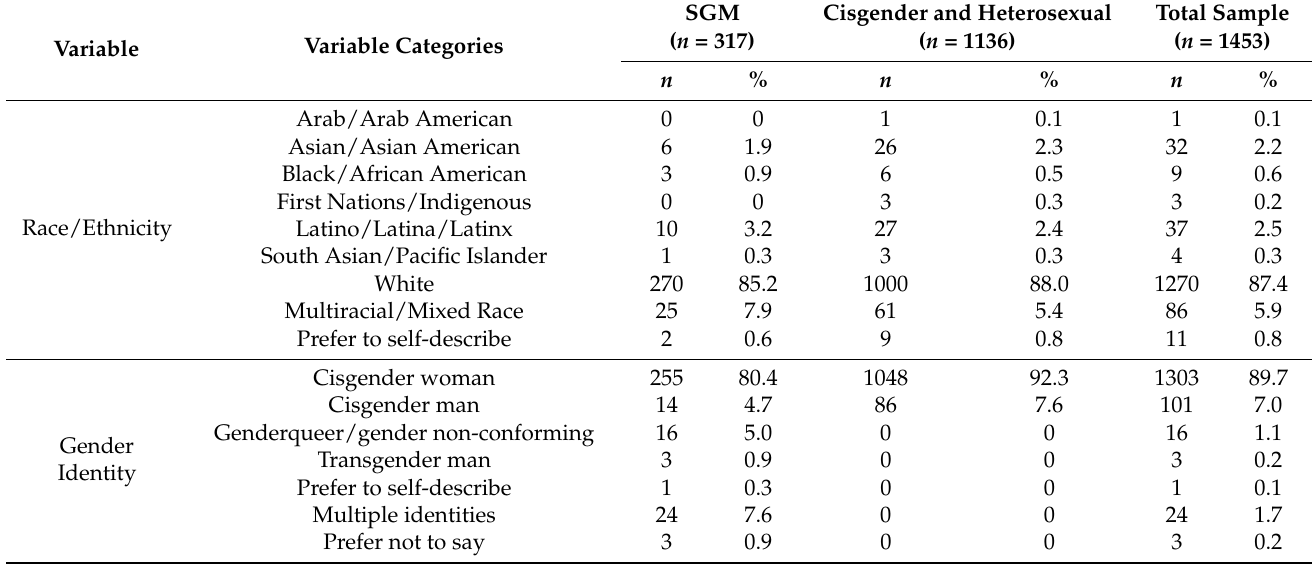
Table 1. Demographic characteristics of sample ( n =